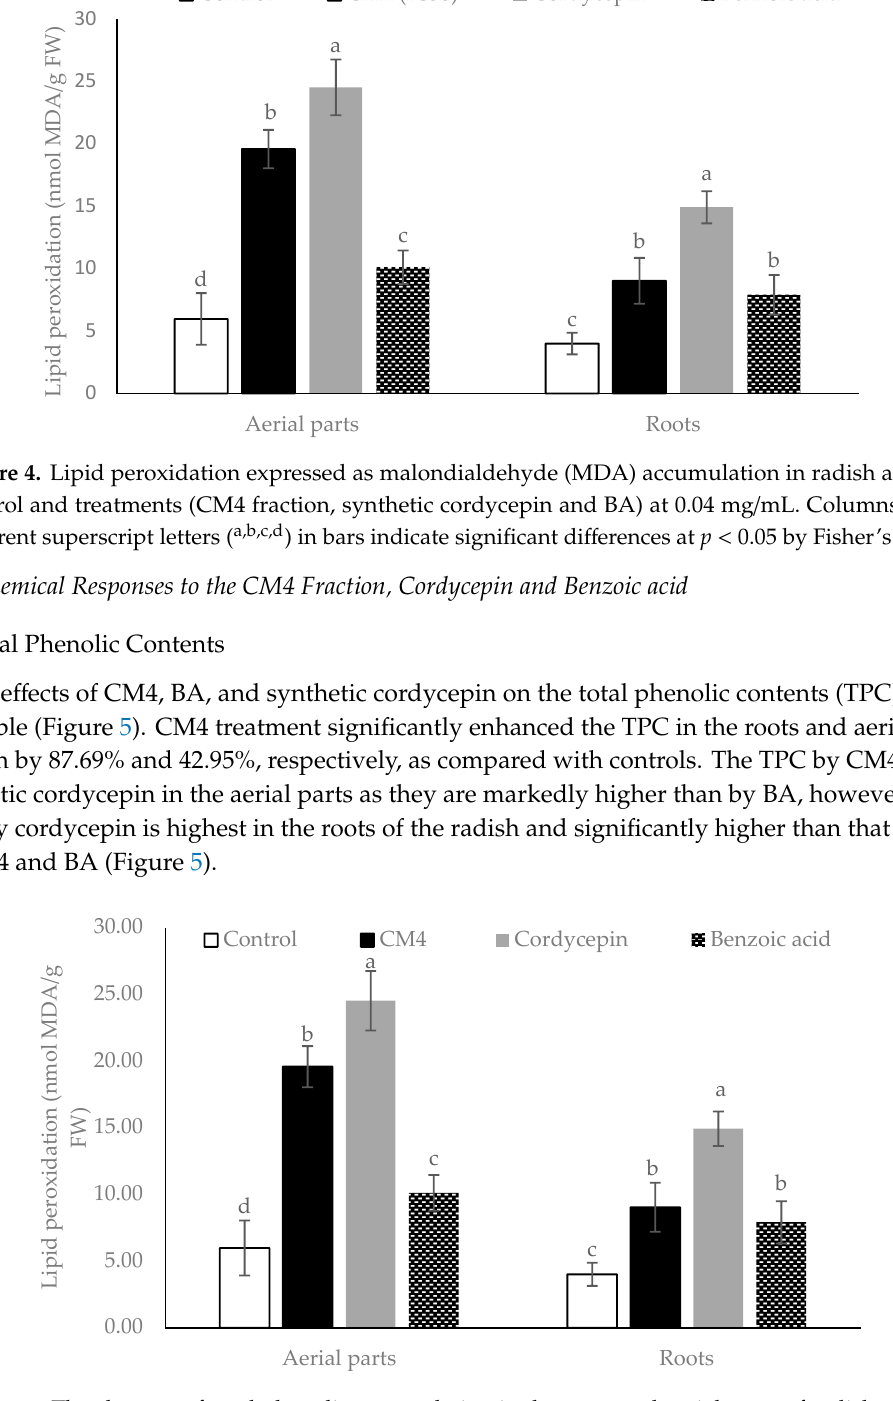
Figure 5. The changes of total phenolic accumulation in the roots and aerial parts of radish among control, CM4 fraction, synthetic cordycepin and BA at 0.04 mg/mL. Columns with similar superscript letters ( a,b,c,d ) were not significantly different at p < 0.05 by Fisher’s test.